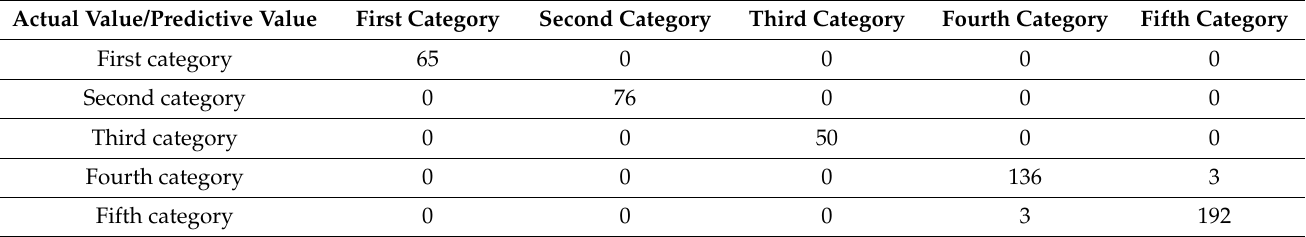
Table 6. Confusion matrix of ship trajectory image test set.